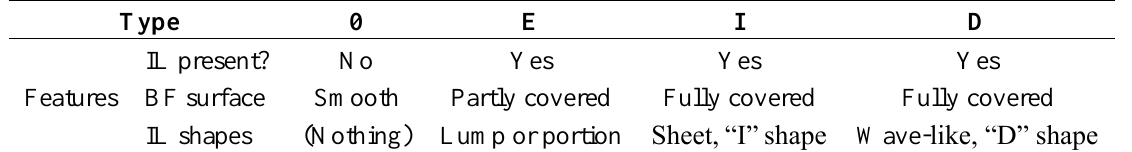
Table 2. The features of the IL